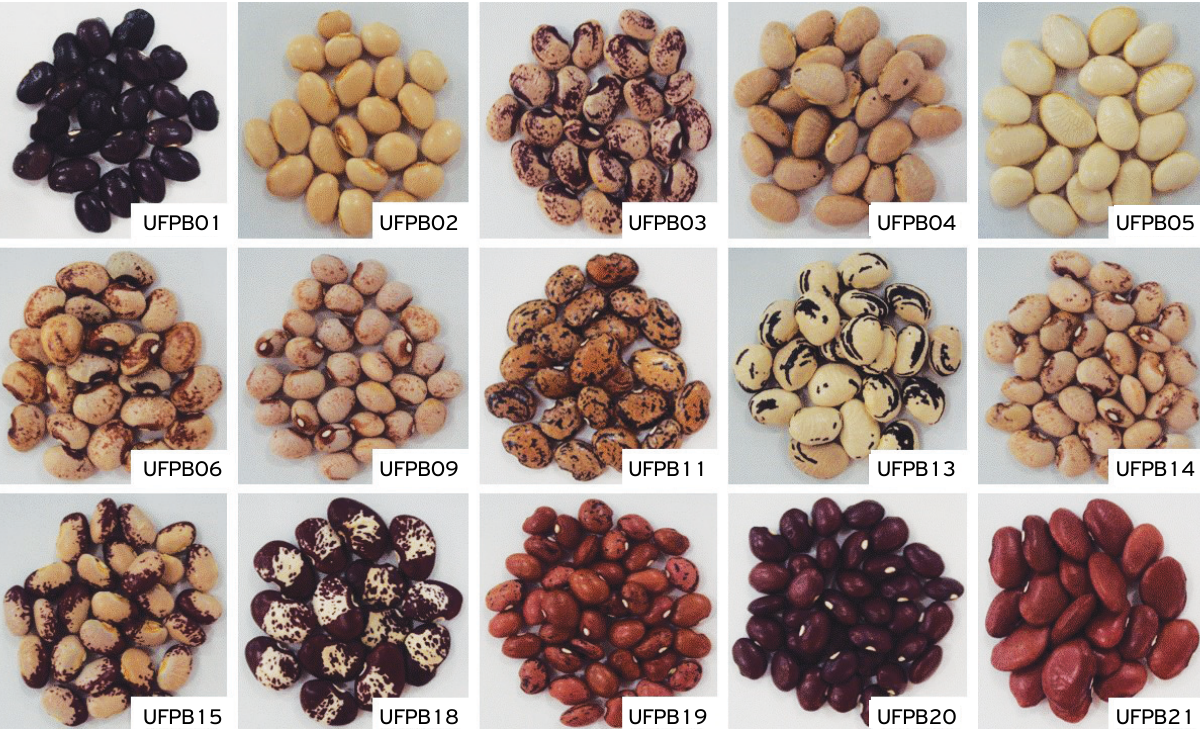
Figure 1. Accessions of fava bean ( Phaseolus lunatus L.) cultivated in greenhouse. The plants were treated with resistance inducers and artificially inoculated with Colletotrichum truncatum